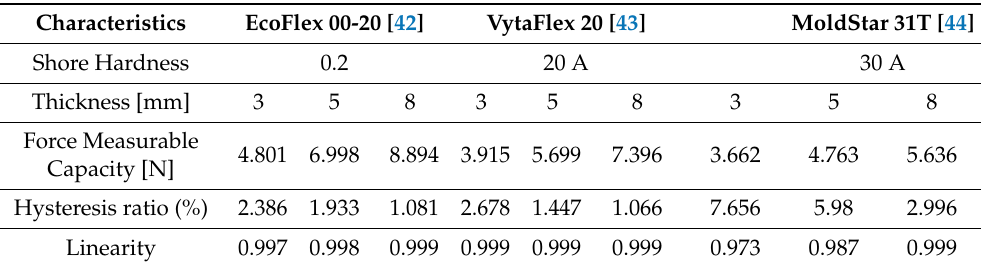
Table 1. Characteristics of BPSC-based sensors according to the type of cast soft material with different shore hardness (0.2, 20, and 30 A) and thicknesses (3, 5, and 8 mm). Characteristics EcoFlex 00-20 [42] Shore Hardness Force